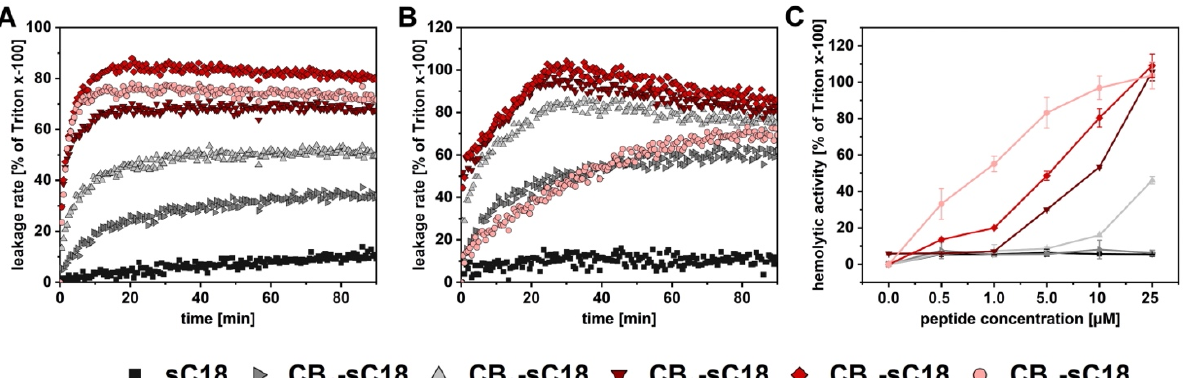
Figure 2. Time-dependent release of CF from negatively charged ( A ) or zwitterionic LUVs ( B ). Data were normalized to Triton x-100 control. ( C ) Hemolytic activity of CB-sC18 conjugates towards RBCs. Data were normalized to the control. Experiments were conducted in duplicate ( A / B ) or triplicate ( C ) with n = 2 .